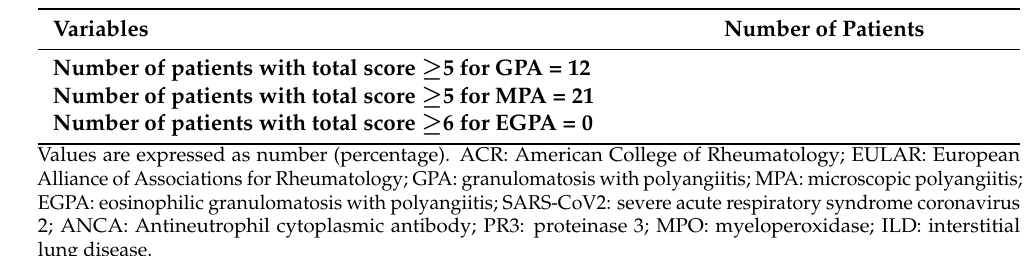
Table 3. Classification of each patient infected by SARS-CoV-2 with positive detection of ANCA based on items of the 2022 ACR/EULAR criteria met by at least one patient. Classification Criteria